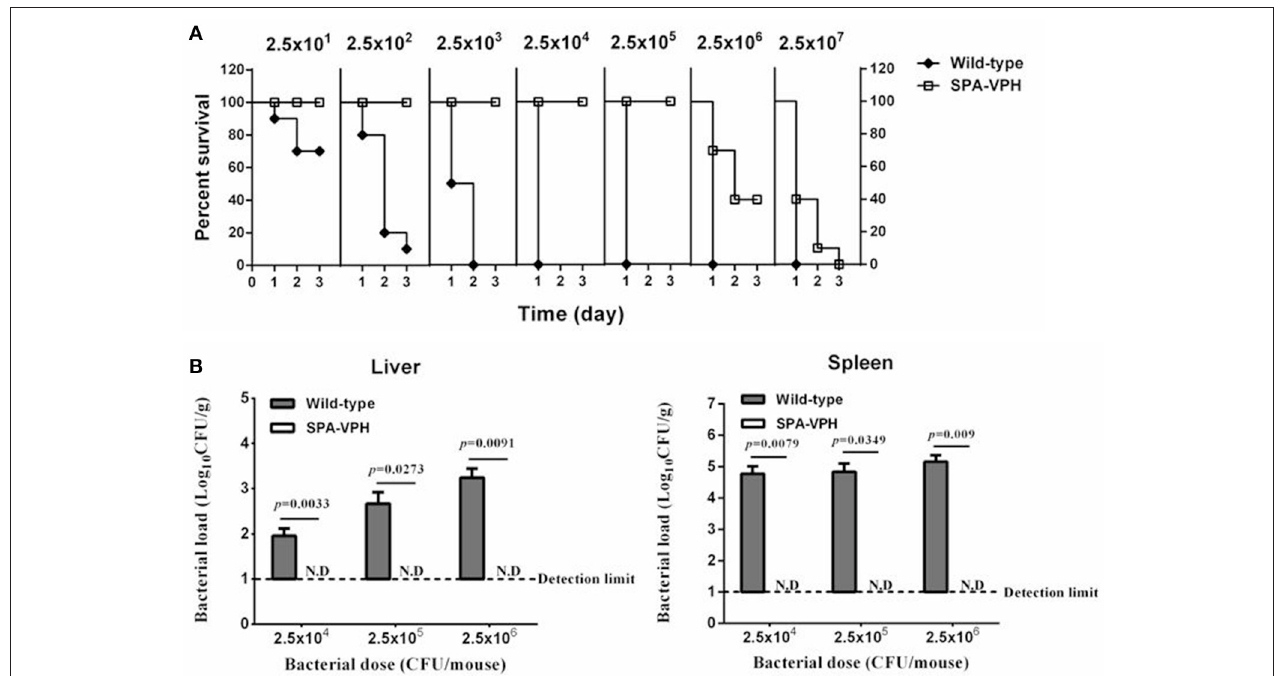
FIGURE 3 | Deletions of phoPQ and htrA in the viaB -containing Salmonella enterica serovar Paratyphi A led to dramatic attenuation in mice model. (A) Survival curve of mice challenged with tested strains. The LD 50 of S . Paratyphi A wild-type and SPA-VPH was assessed in a mucin mouse model. BALB/c mice were challenged with tested bacteria suspended in 10% hog gastric mucin by intraperitoneal injection at indicated doses. Deaths of mice were monitored within 72h. (B) Bacterial burdens in organs of infected mice. Mice were intraperitoneally infected with S . Paratyphi A wild-type and SPA-VPH at indicated doses in the absence of hog gastric mucin. On the 7 day postinfection, bacterial persistence in the livers, and spleens of infected mice was assessed by culture and colony counting of tissue homogenates.